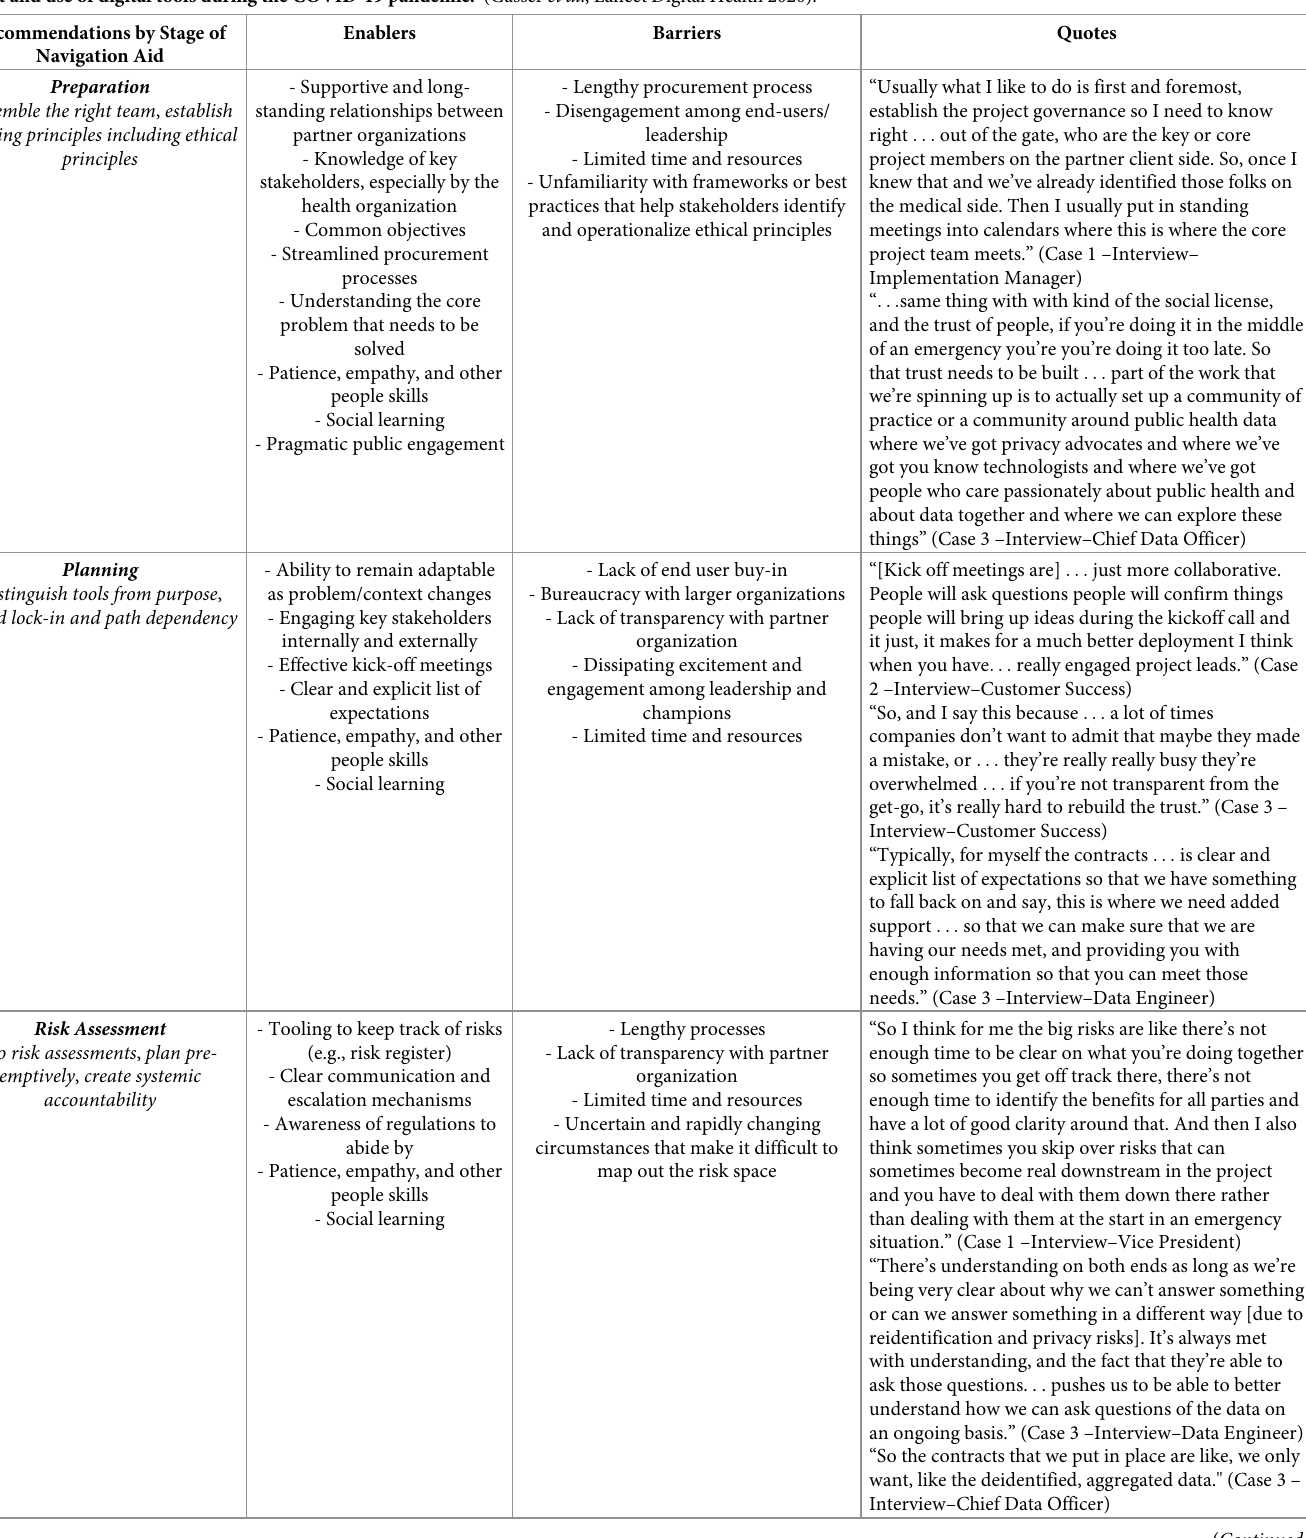
Table 2. Mapping the barriers and enablers identified in our three cases of study to the recommendations in Gasser’ et al .’s navigation aid for the ethical develop- ment and use of digital tools during the COVID-19 pandemic. (Gasser et al ., Lancet Digital Health 2020). Recommendations by Stage of Navigation